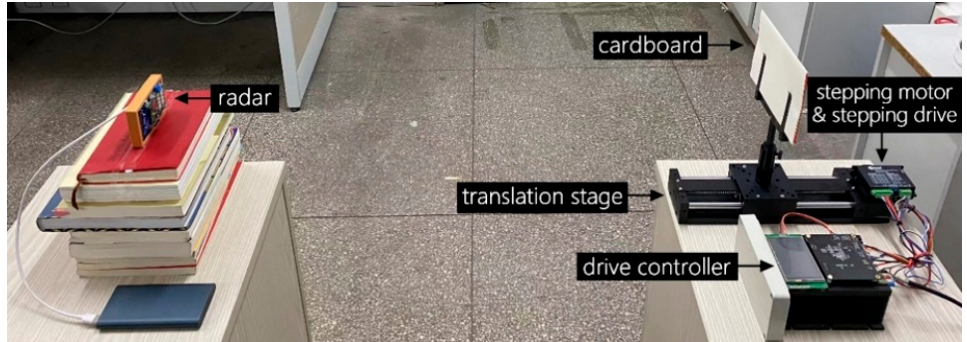
Figure 5. Moving cardboard simulation experiment setup.